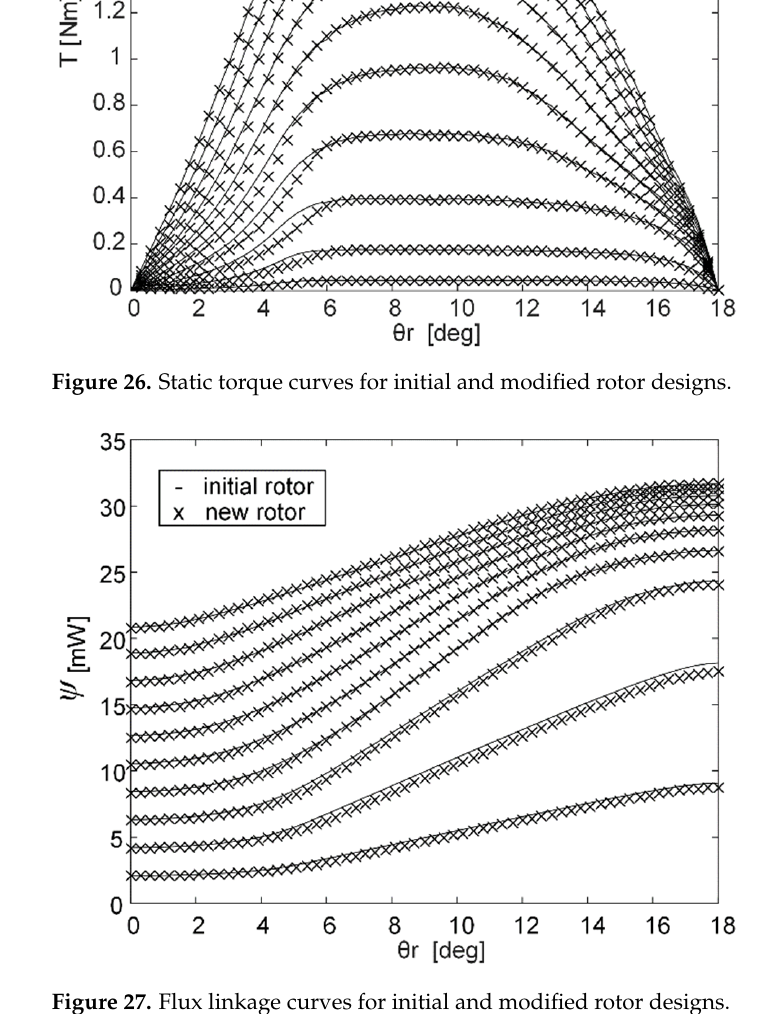
Figure 27. Flux linkage curves for initial and modified rotor designs.